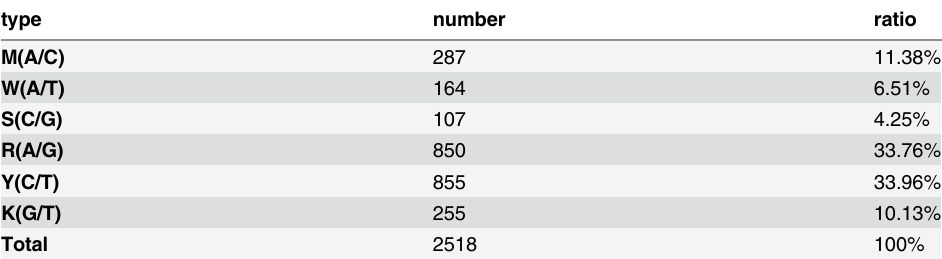
Table 5. Statistic of six types of mapped